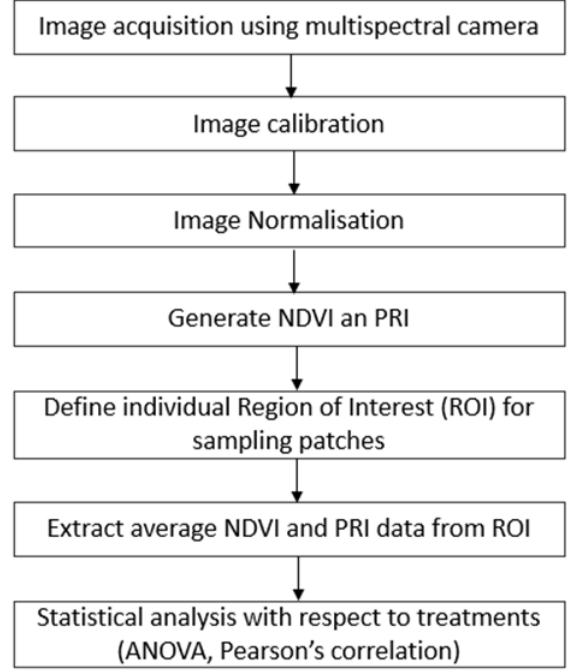
Figure 6. Diagram describing the key image processing and data analysis steps.